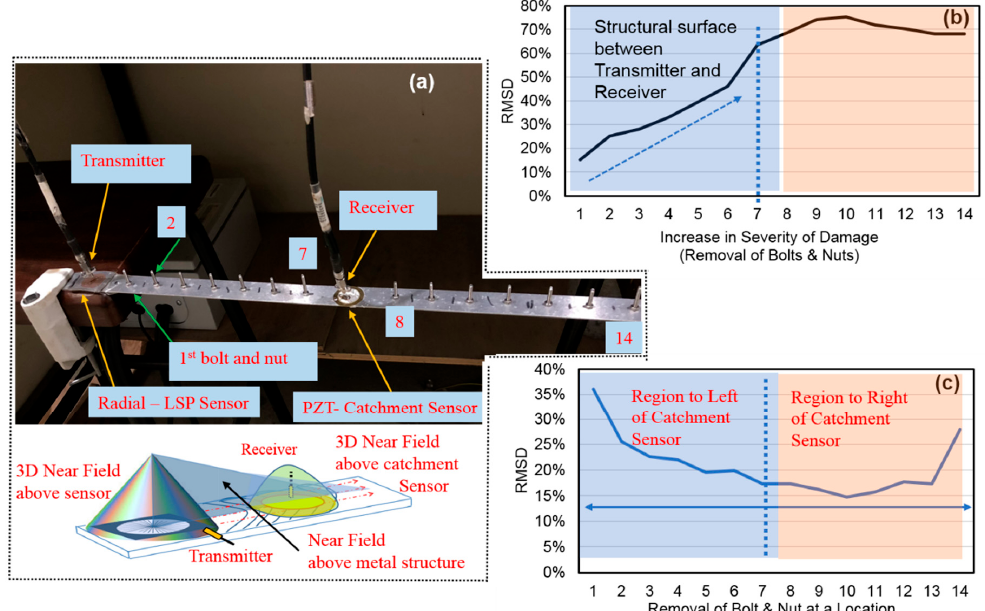
Figure 6. Introduction of catchment sensor and effectiveness in damage detection ( a ) photo and principle of dual sensor application, ( b ) increase in severity of damages on engineering surface between LSP sensor and catchment sensors and beyond catchment sensor, and ( c ) single damage on the specimen at various locations.